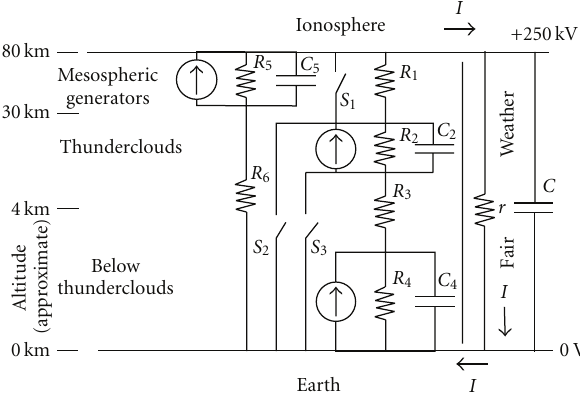
Figure 5: Diagram showing a schematic equivalent circuit for global electric circuits, credit